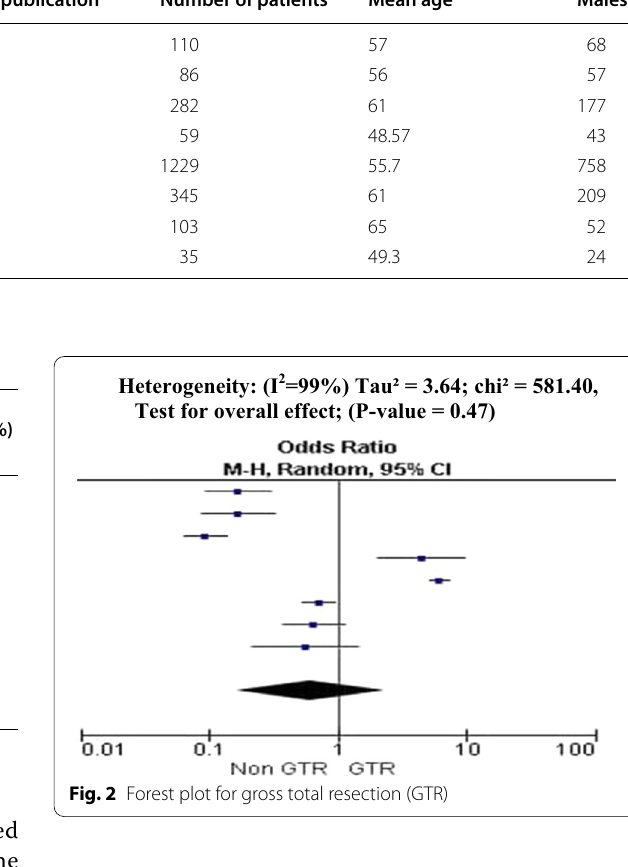
Table 2 Patients characteristics: No.